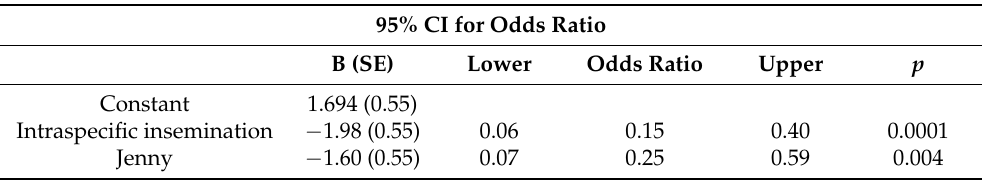
Table 2. Logistic regression predicting the likelihood of pregnancy based on intraspecific or interspe- cific insemination or species of the inseminated female (jenny or mare).